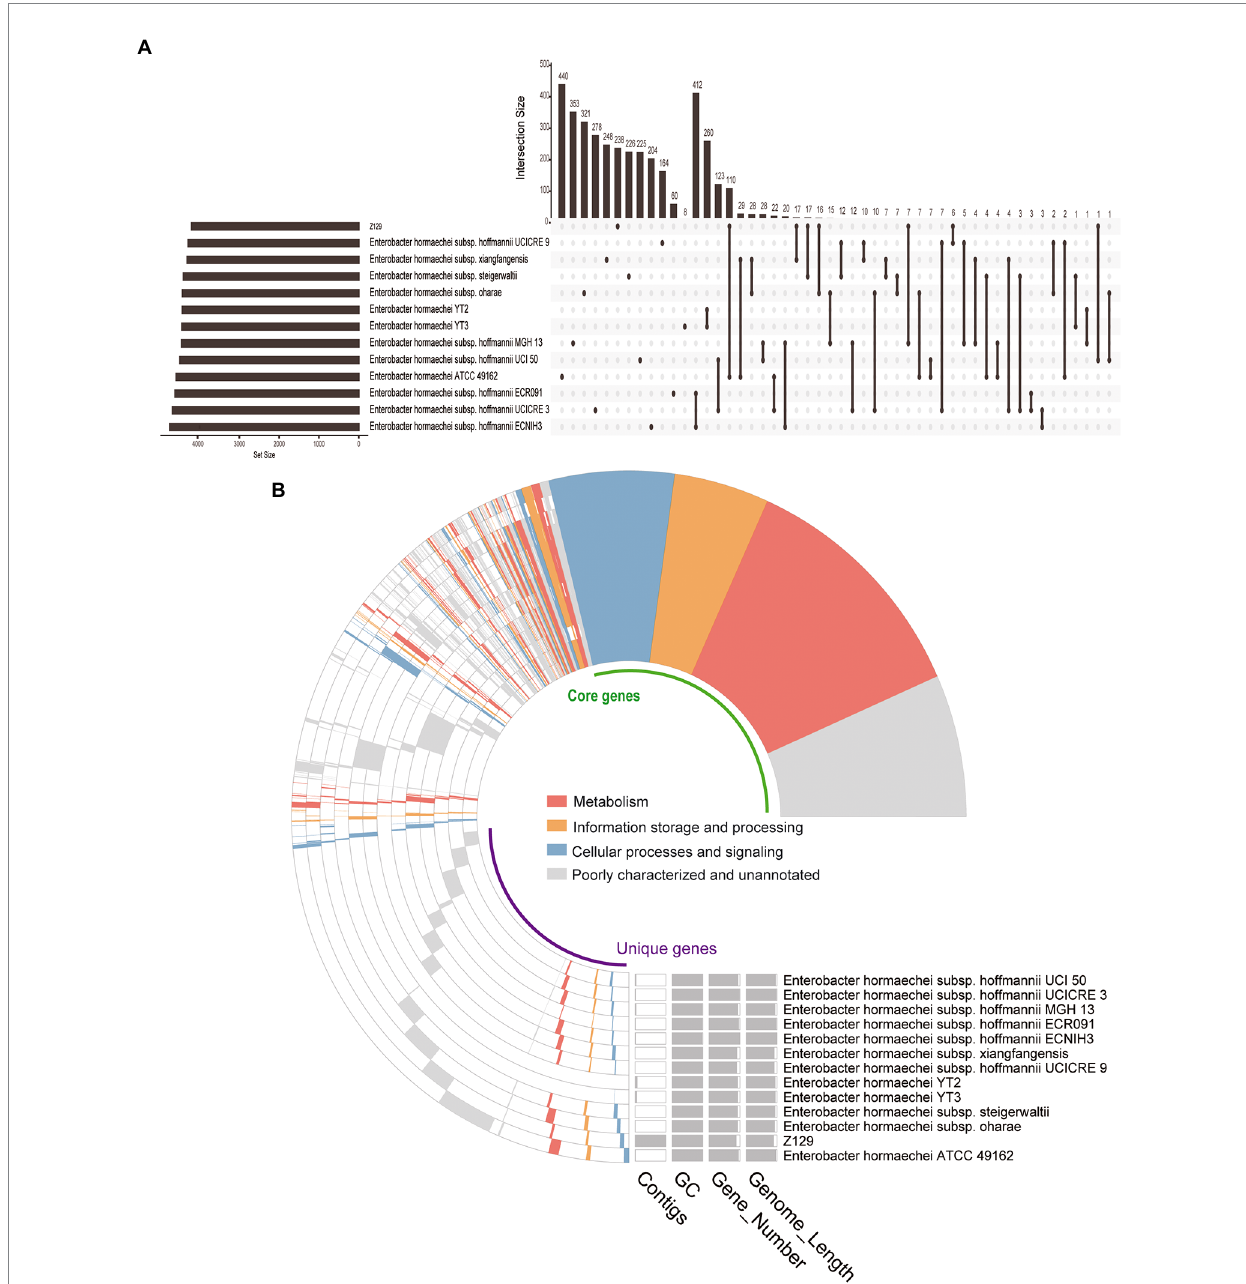
FIGURE 4 Distribution of genes among Enterobacter hormaechei strains. (A) Upset figure showing the unique genes of each strain and genes shared between any two strains. (B) COG annotation showing the core genes, unique genes, number of contigs, GC content, and genome